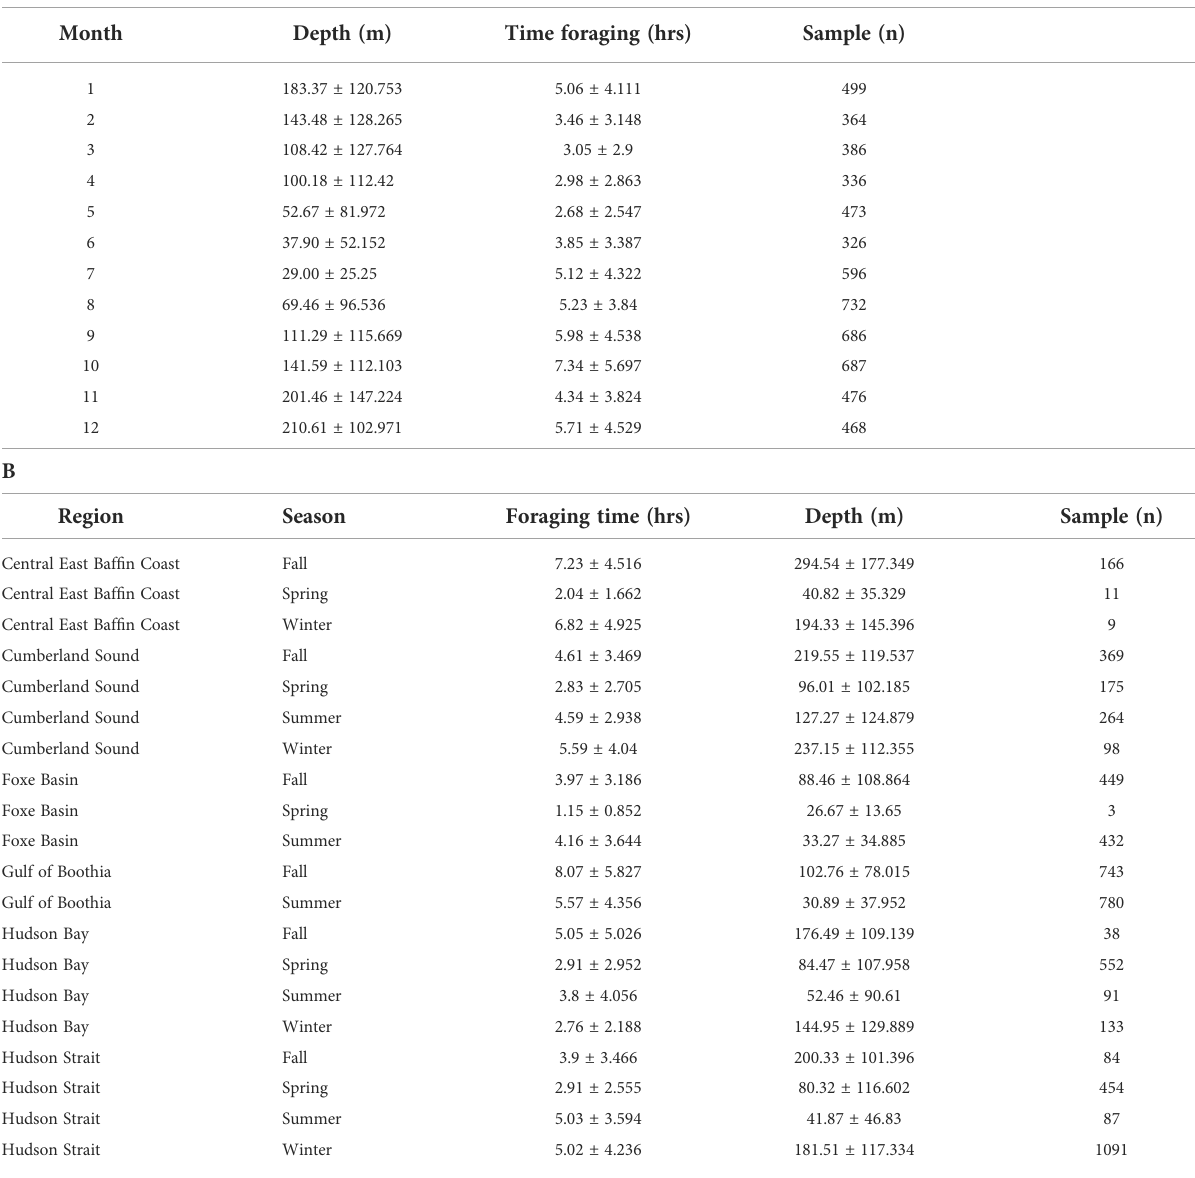
TABLE 5 Summary information about the Depth (m) of probable foraging of bowhead whales based on the maximum depth and minimum duration [Time foraging (hrs)] of square-shaped dives (Sample n=6,029) by A: month with data pooled across individuals and years and B: region and season. Data are expressed as mean ±